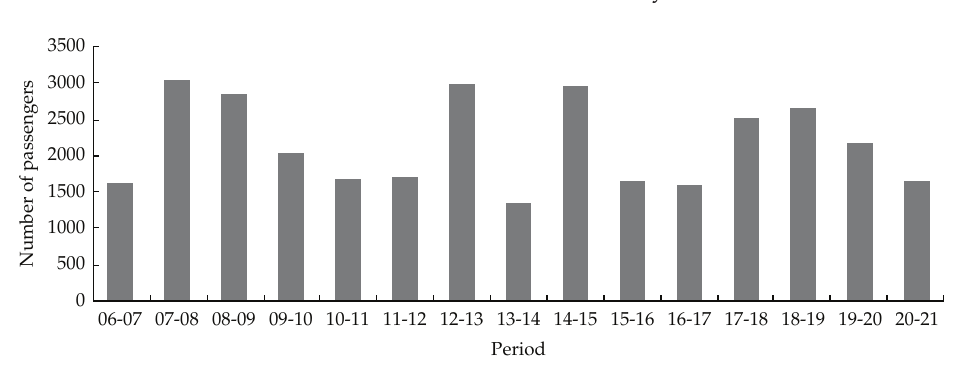
Figure 7: The period-dependent passenger demands counted in terms of one hour.